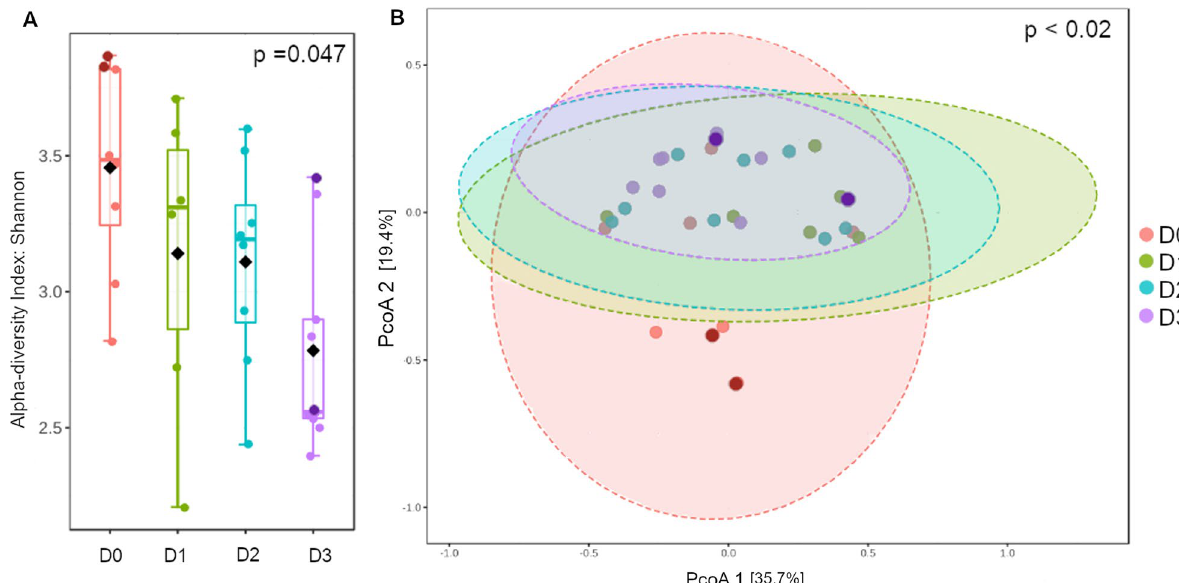
Fig. 3 Alpha ( A ) and beta ( B ) diversity measures of the four scenarios: D0, D1, D2 and D3. Boxplot of Shannon’s Diversity Index (Kruskal–Wallis statistic: 7.935; p 0.047) is depicted in panel ( A ). A PcoA of Bray–Curtis distance matrix (ANOSIM’s R: 0.12; p < 0.02) is shown in panel ( B ). Different = color intensities in dots from scenarios D0 and D3 are used to indicate the different localities sampled within each scenario (Additional file 1: Figure S1 and Table S1 and S2)